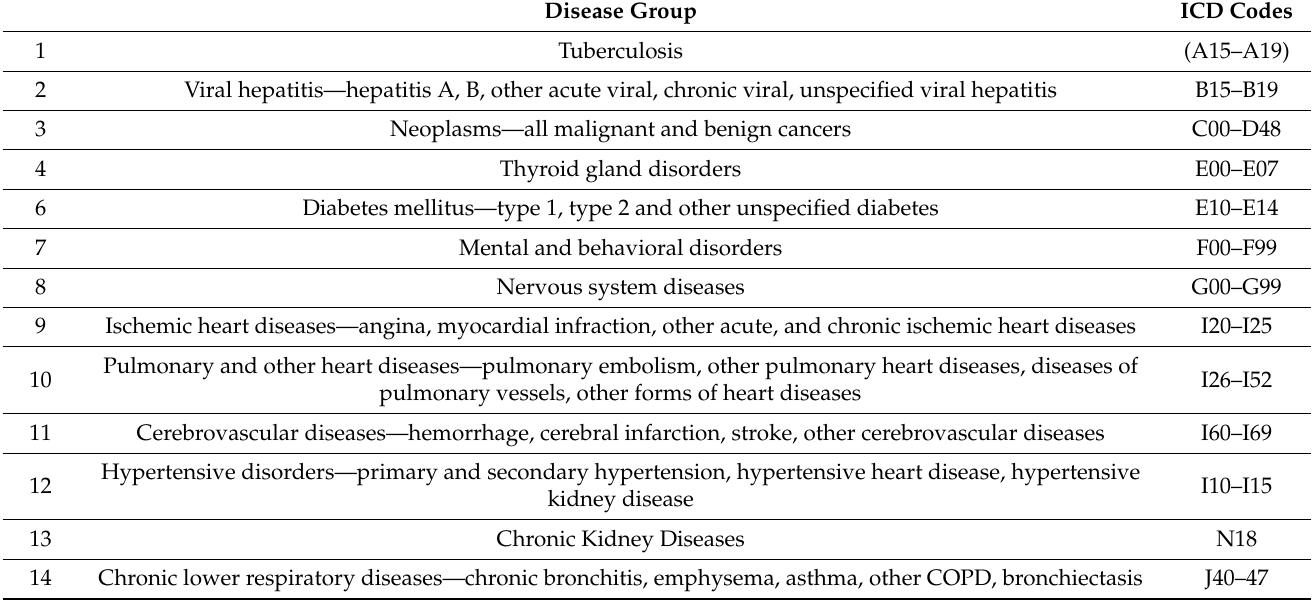
Table A1. Grouping of diseases according to ICD10 classification.